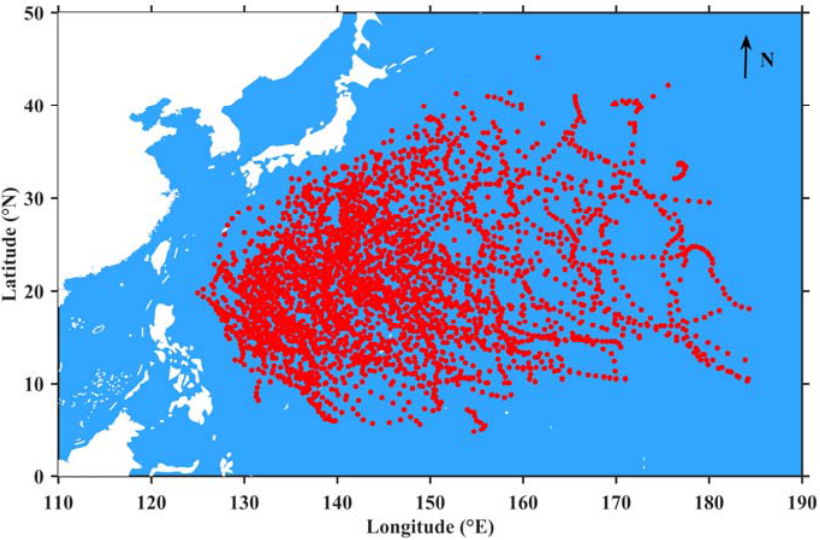
Figure 1. Distribution of tropical cyclones (red points).